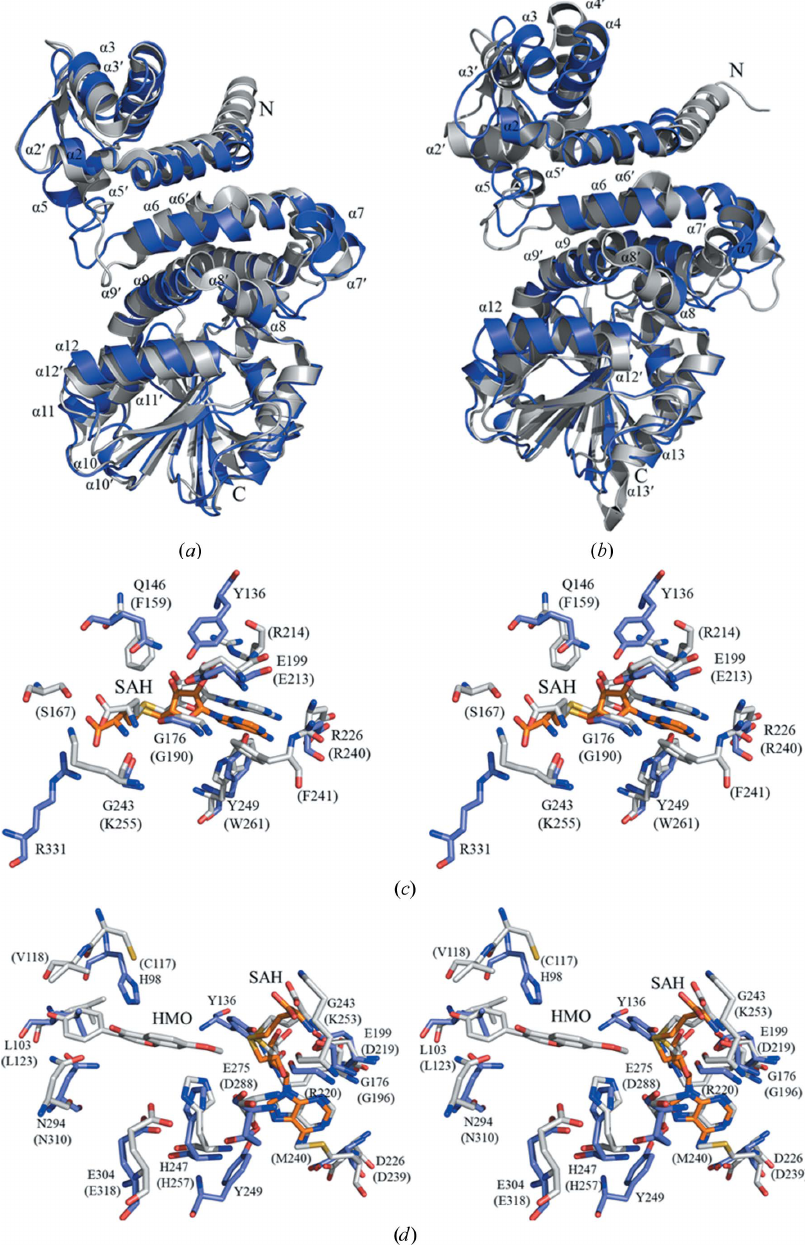
Figure 7 Structural comparison of the active site of PigF with those of MmcR and IOMT. ( a , b ) Structure comparison of PigF–SAH with MmcR (PDB entry 3gwz) ( a ) and IOMT (PDB entry 1fp2) ( b ). PigF–SAH is coloured blue and MmcR and IOMTare coloured grey. ( c , d ) Diagrams showing the superimposed binding sites of PigF–SAH and MmcR ( c ) and IOMT ( d ). The residues and SAH in PigF–SAH are coloured blue and orange, respectively, and labelled in black; the residues and SAH in MmcR and IOMT are coloured grey and labelled black in